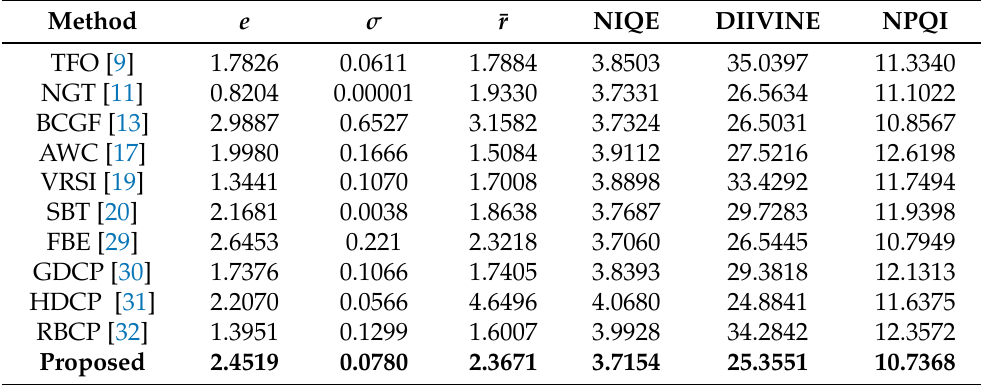
Table 2. Average results of non-reference evaluation of 375 sand dust